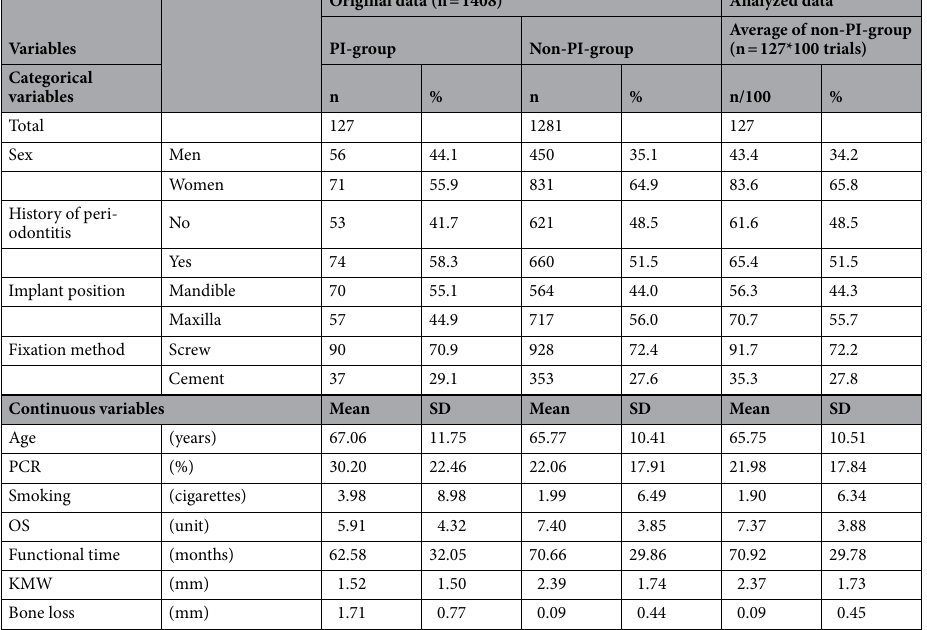
Table 1. Characteristics of evaluated and analyzed implants. Average of non-PI-group show the mean value of non-PI in the analyzed population obtained from 100 trials. SD: standard deviation, PCR: plaque control record, OS: number of occlusal supports, KMW: keratinized mucosa width.